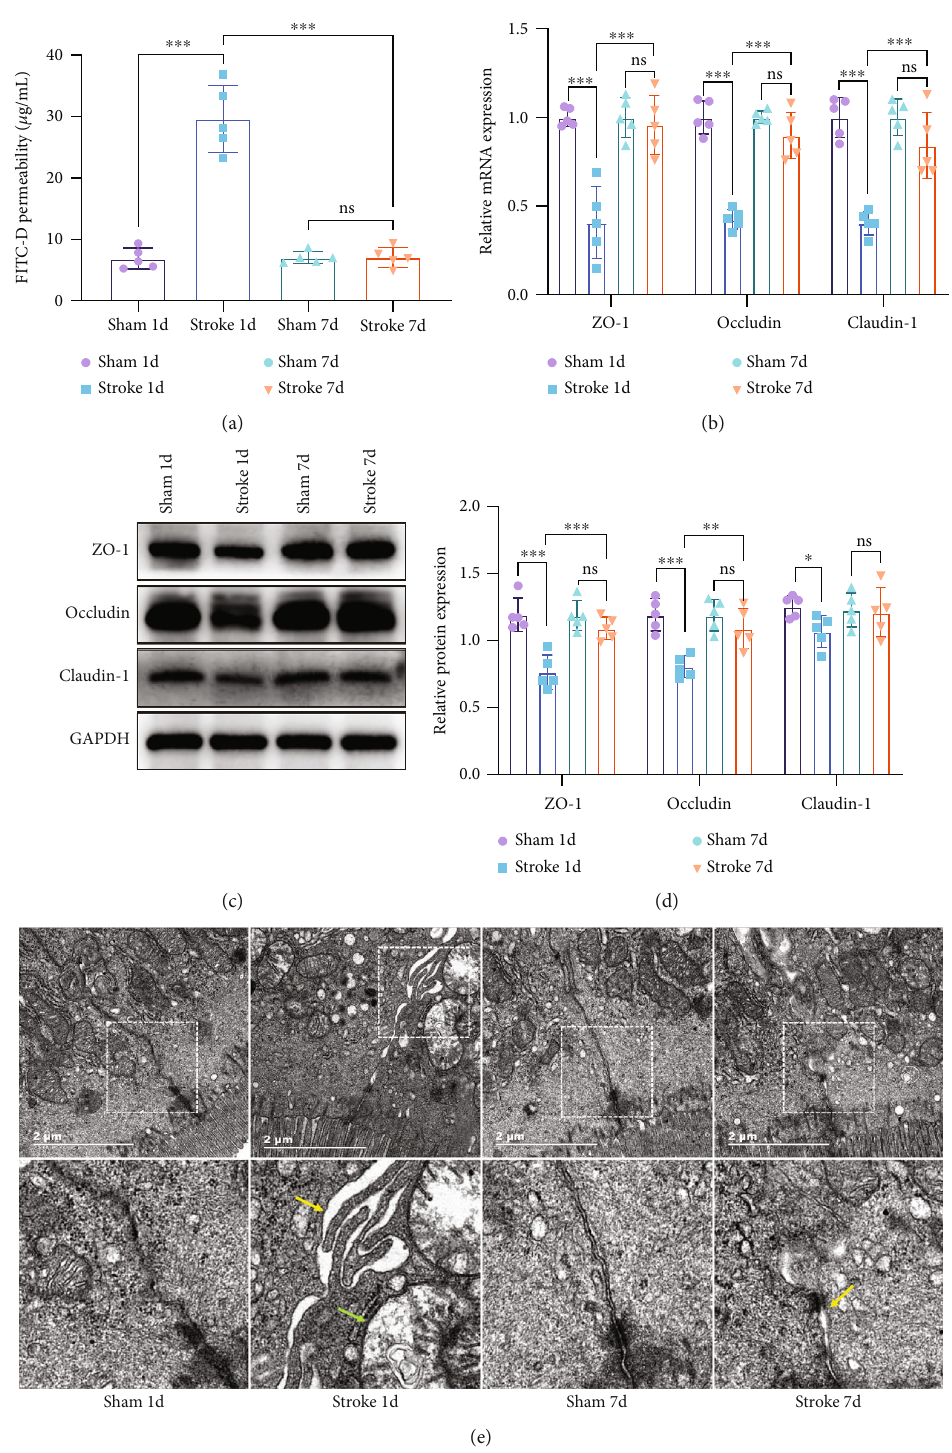
Figure 4: Ischemic stroke leads to increased intestine permeability. (a) Quantitative analysis of serum FITC-D as a measure of intestinal barrier functions ( n = 5 ). (b) mRNA levels of ZO-1, occludin, and claudin-1 were measured with RT-qPCR and normalized to the expression levels of β -actin ( n = 5 ). The results were presented as fold changes relative to the sham group. (c, d) Representative western blots and quanti fi cation data of ZO-1, occludin, claudin-1, and GAPDH for each group ( n = 5 ). Two-way ANOVA with Tukey ’ s multiple comparison test. Data were expressed as mean ± standard deviation . ∗ p < 0 : 05 , ∗∗ p < 0 : 01 , and ∗∗∗ p < 0 : 001 . ns: not signi fi cant. (e) Representative images of transmission electron microscopy (TEM) (magni fi cation × 23000). The ultrastructure of the normal small intestinal mucosa looked like that of sham 1d and sham 7d, including perfect tight junctions (TJ) and normal mitochondria (yellow arrow points to enlarged tight junction, and green arrow points to degenerate mitochondria). Scale bar: 2 μ